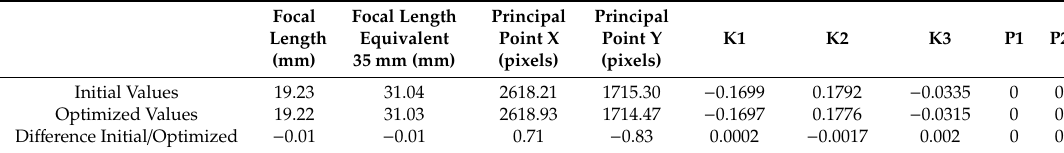
Figure 2. Block diagram of the proposed framework.